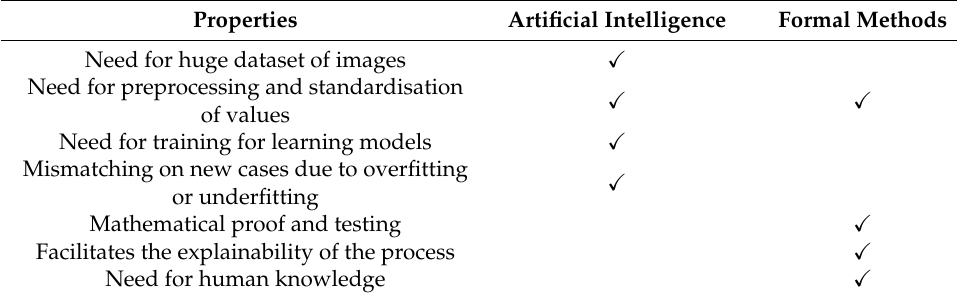
Table 7. Pros and cons of the actual technologies helping medical